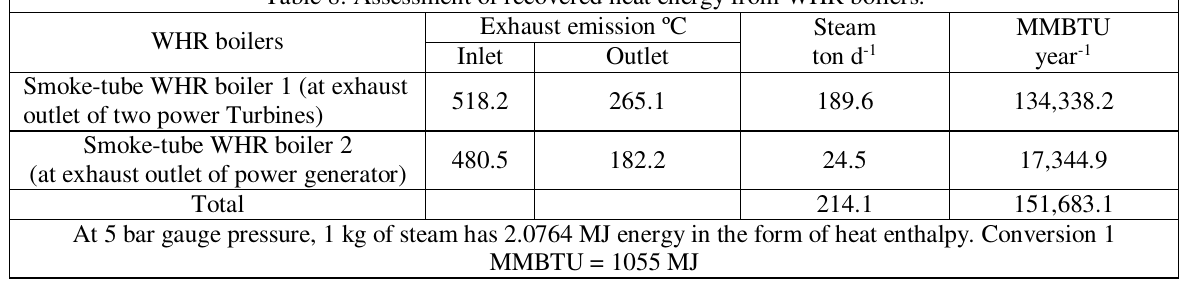
Table 8: Assessment of recovered heat energy from WHR